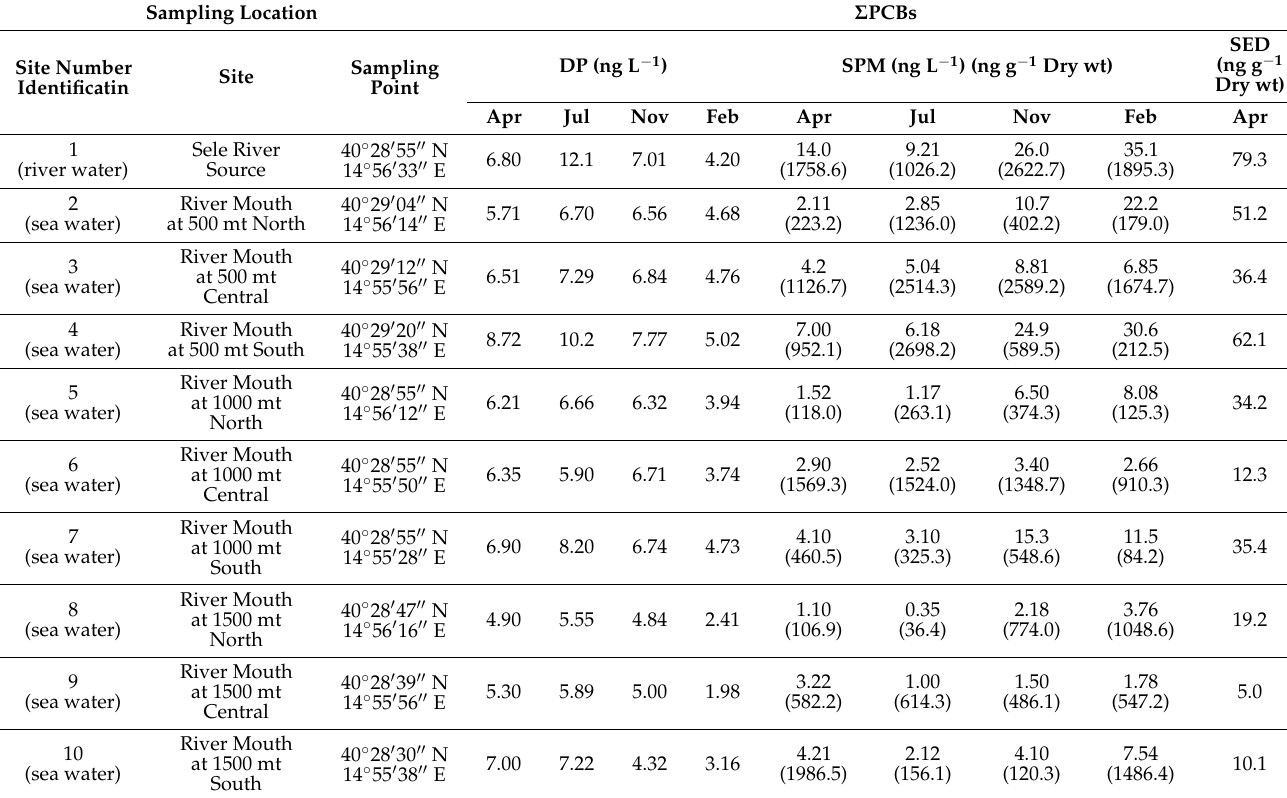
Table 1. Total PCBs concentrations in the three phases (DP, SPM, SED) analyzed from the samples collected from the Sele river, southern